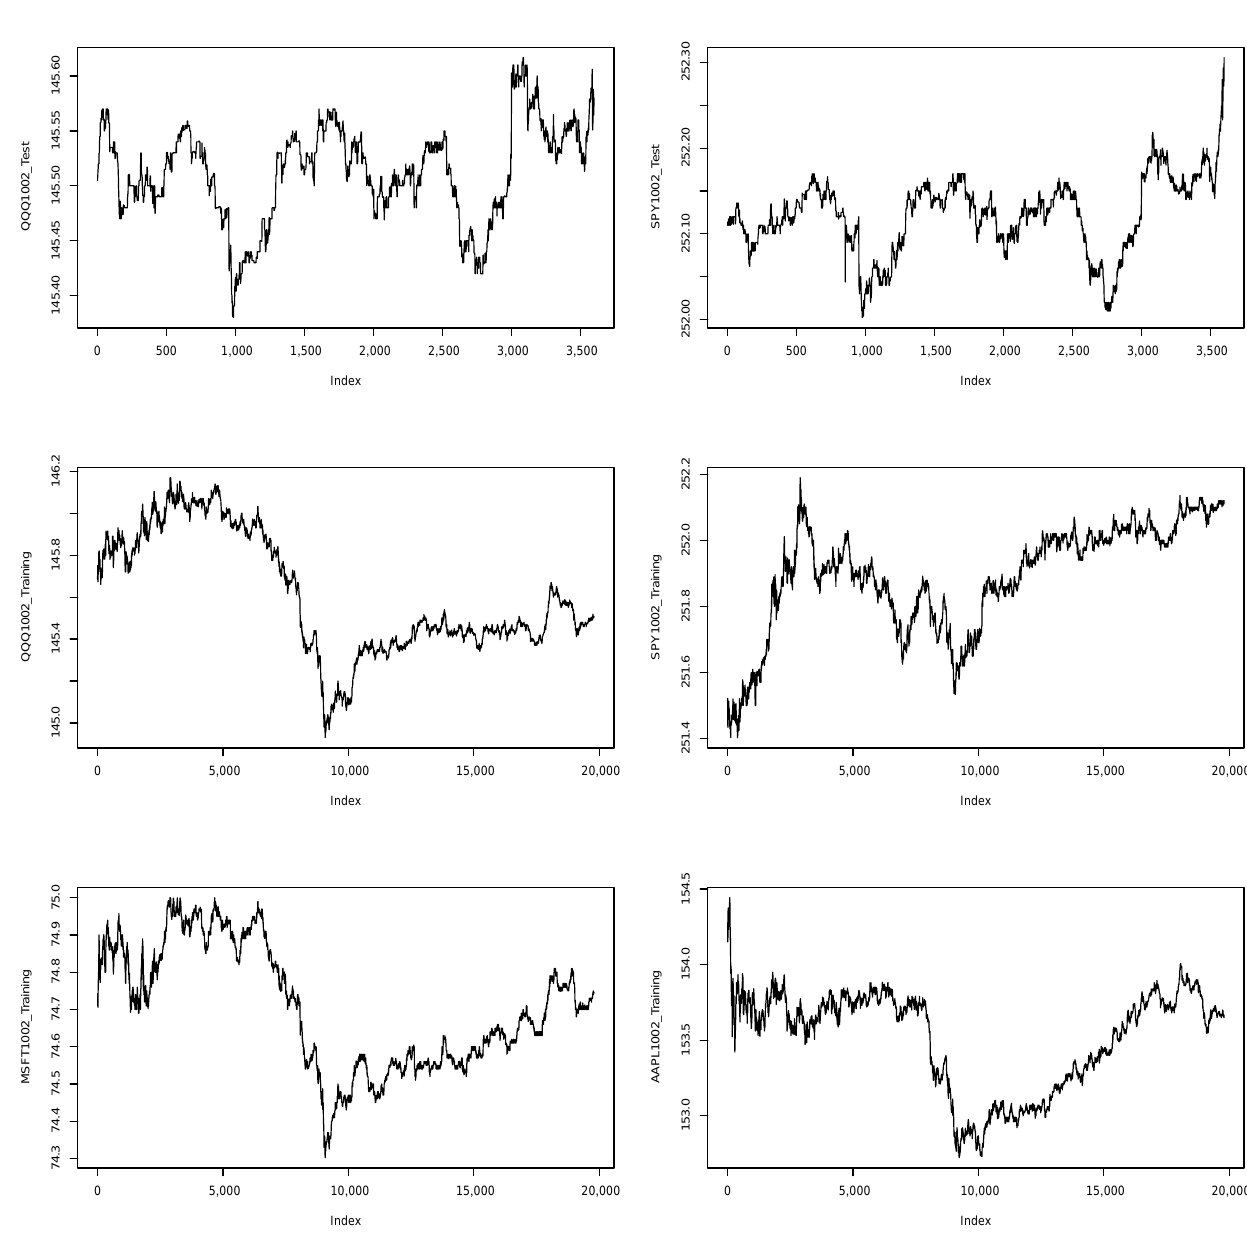
Figure 1. Case 1—Second-level QQQ ETF and SPY ETF prices time series on day 1 (10 February